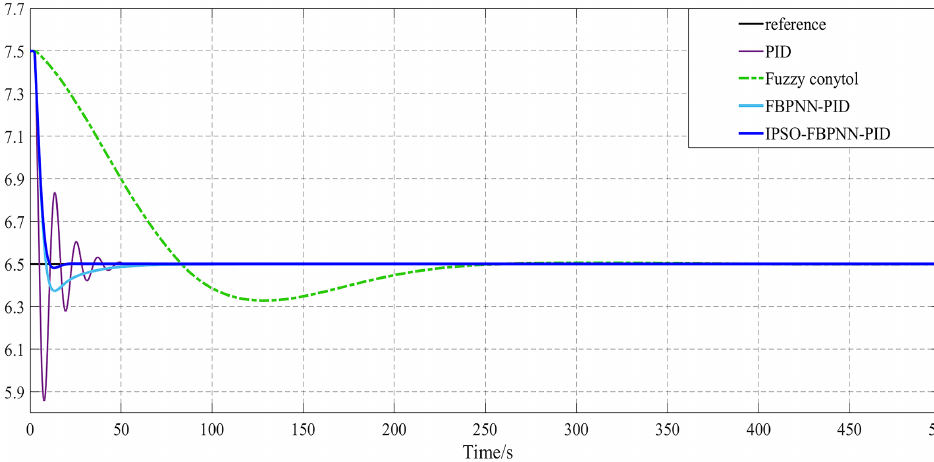
Figure 14. Control analysis and comparison chart of different controllers. Table 2. Comparison table of performance parameters of four control algorithms.